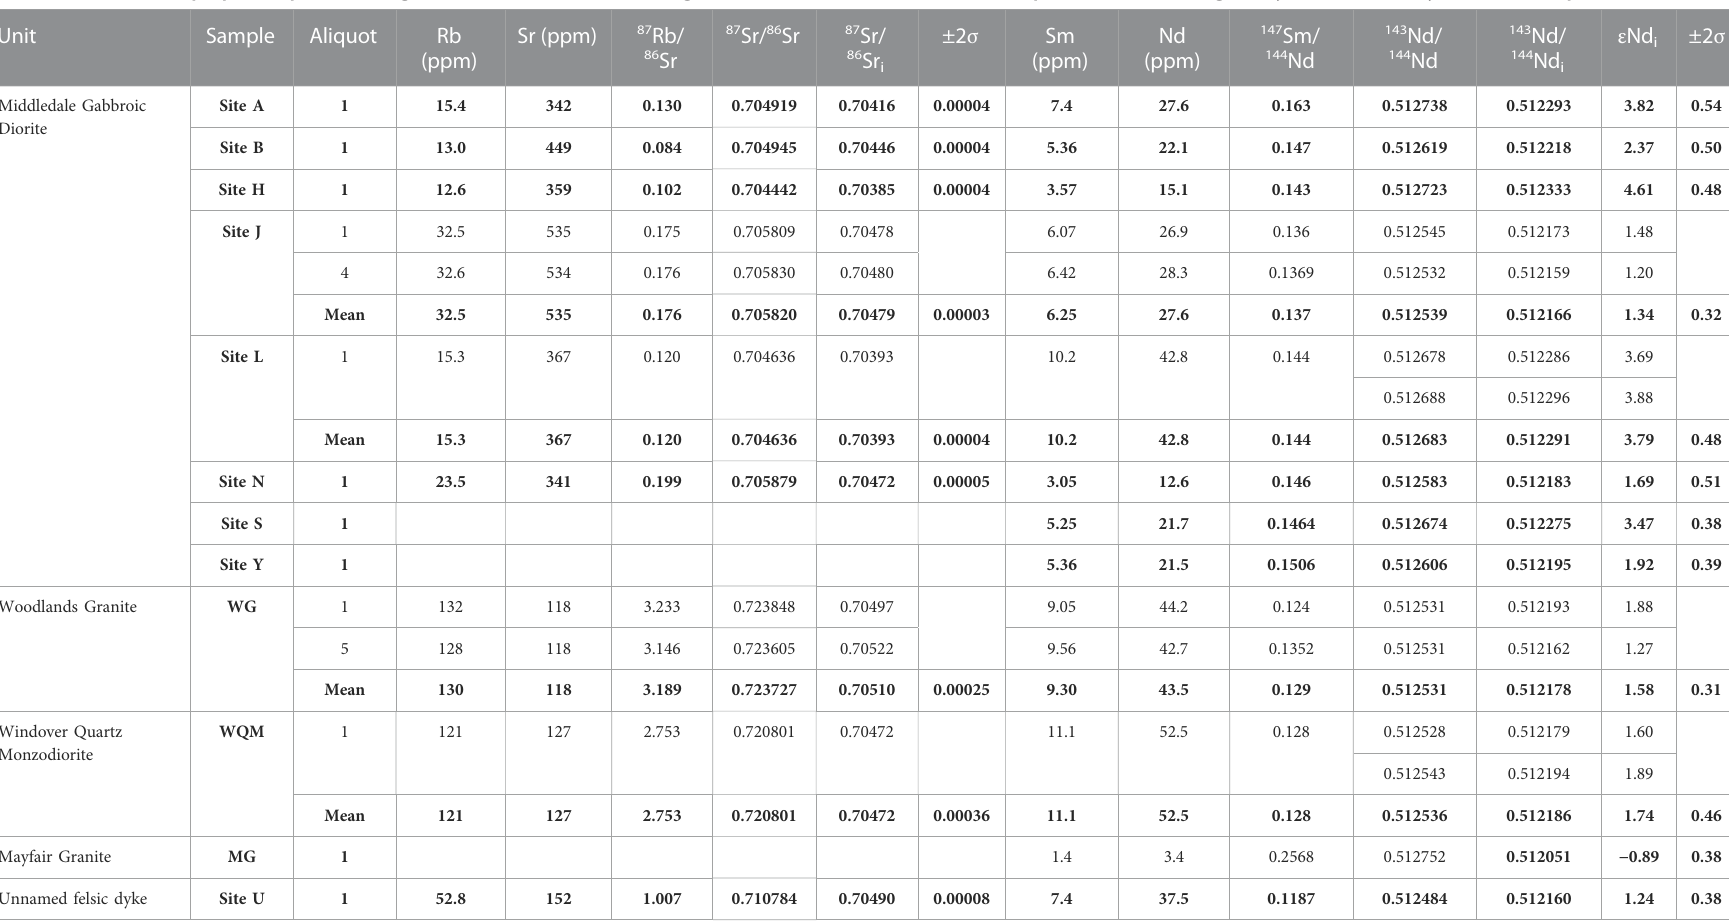
TABLE 1 Wallundry Suite Rb-Sr and Sm-Nd data acquired by MC-ICPMS. Samples have been age corrected to 416.8 (Black et al., 2004; Iles, 2012). The ε Nd i values have been calculated using the modern CHUR values 147 Sm/ 144 Nd = 0.1960and 143 Nd/ 144 Nd=0.512632(adjustedforLaJolla=0.511860)ofBouvieretal.(2008).Valuesinitalicsaredataderivedfromatraceelementrunofseparatealiquots,pairedwith 87 Sr/ 86 Srand 143 Nd/ 144 Nddeterminations